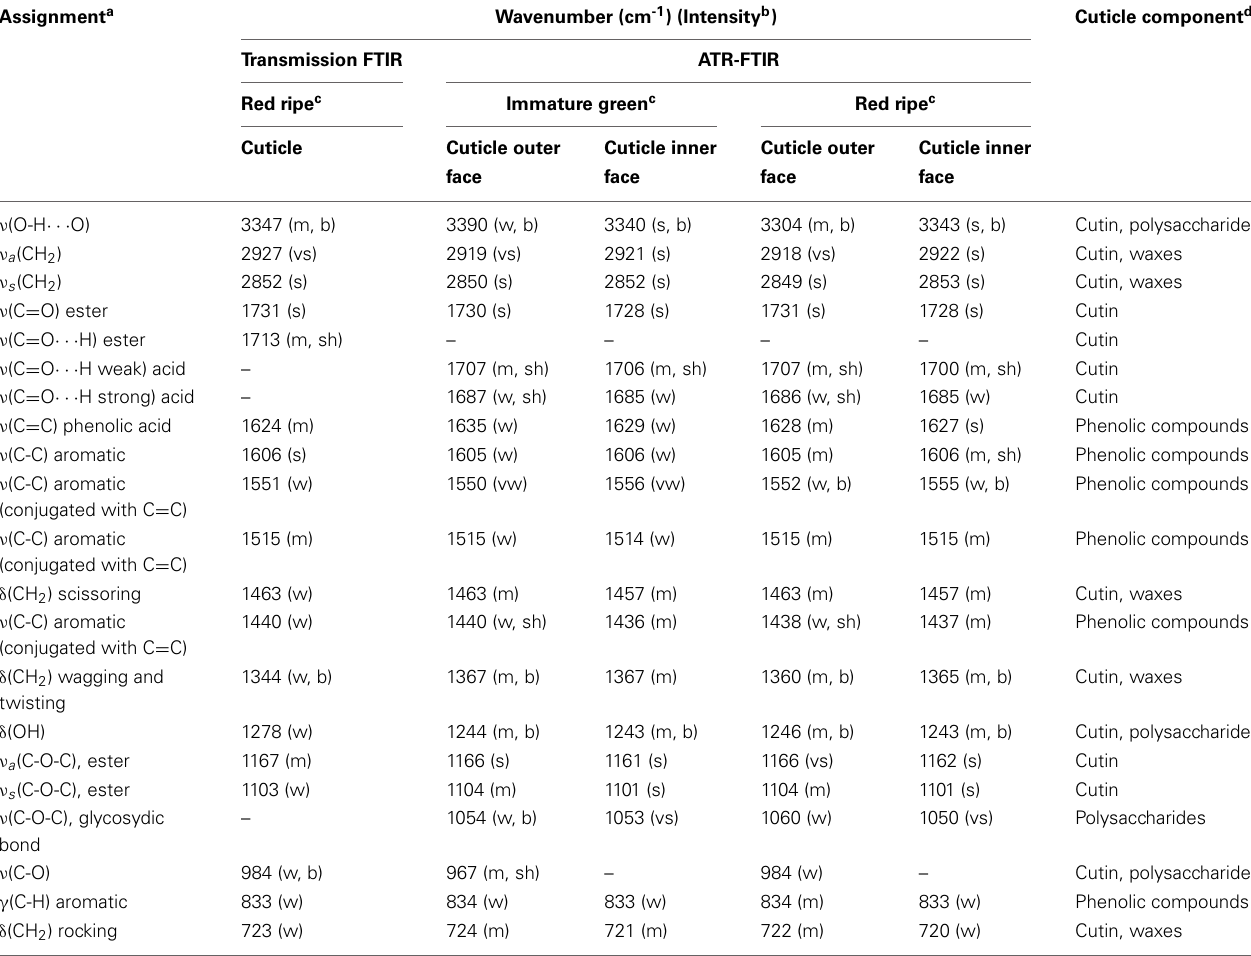
Table 1 | Main functional groups assigned to the different vibrations present in the transmission (red ripe stage) and ATR-FTIR (immature green and red ripe stages) spectra of tomato ( Solanum lycopersicum ) fruit cuticle (adapted from Ramírez et al., 1992; España et al.,